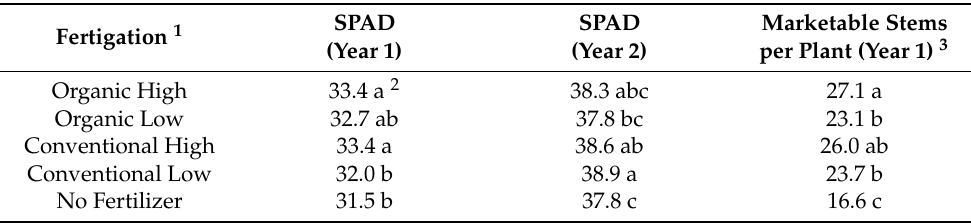
Table 4. Effects of fertigation during the growing season on leaf SPAD readings (taken 26 days after transplanting in both years) and number of marketable stems per plant of zinnia “Benary’s Giant Mix” grown in a high